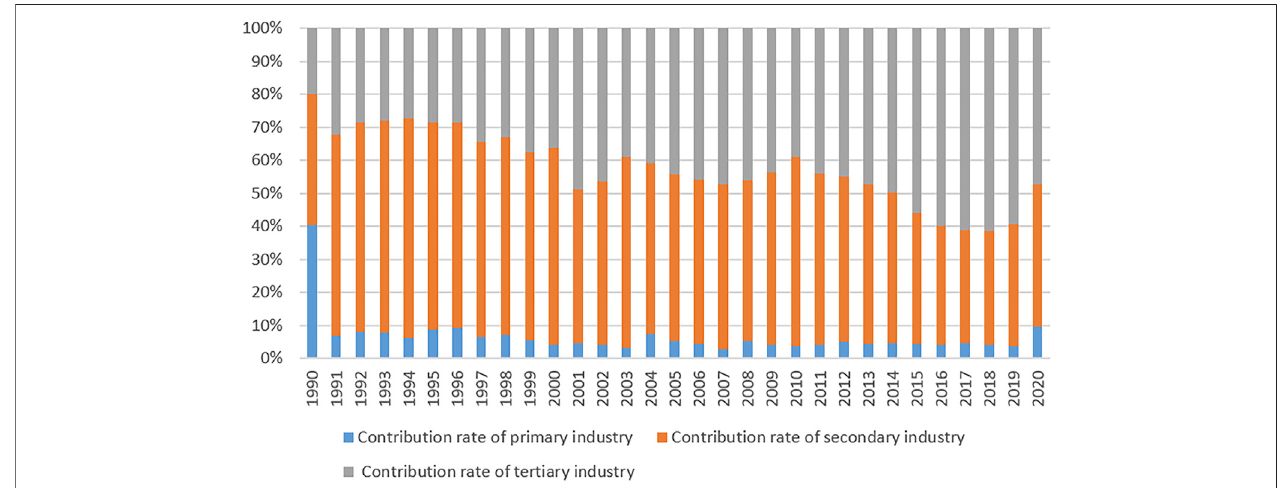
FIGURE 5 | China ’ s industrial structure, 1990 – 2020. Data source: China Statistical Yearbook